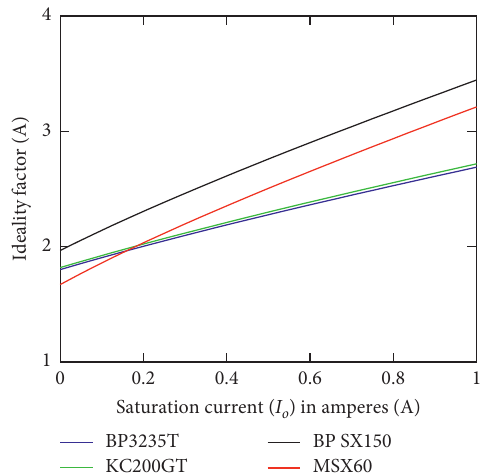
Figure 2: A graph of A vs I o for BP3235T, KC200GT, BP-SX 150, and MSX60 PV